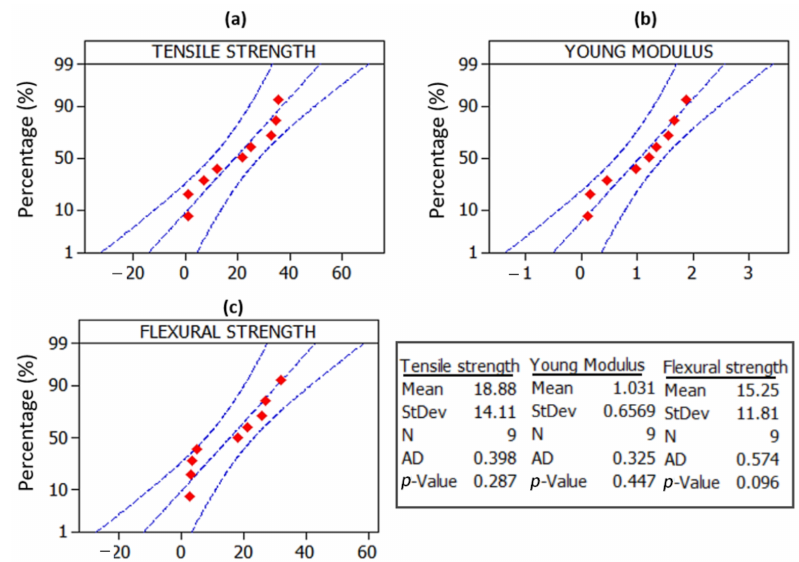
Figure 6. Normal probability plots of ( a ) tensile strength ( b ) Young’s modulus and ( c ) flexural strength.